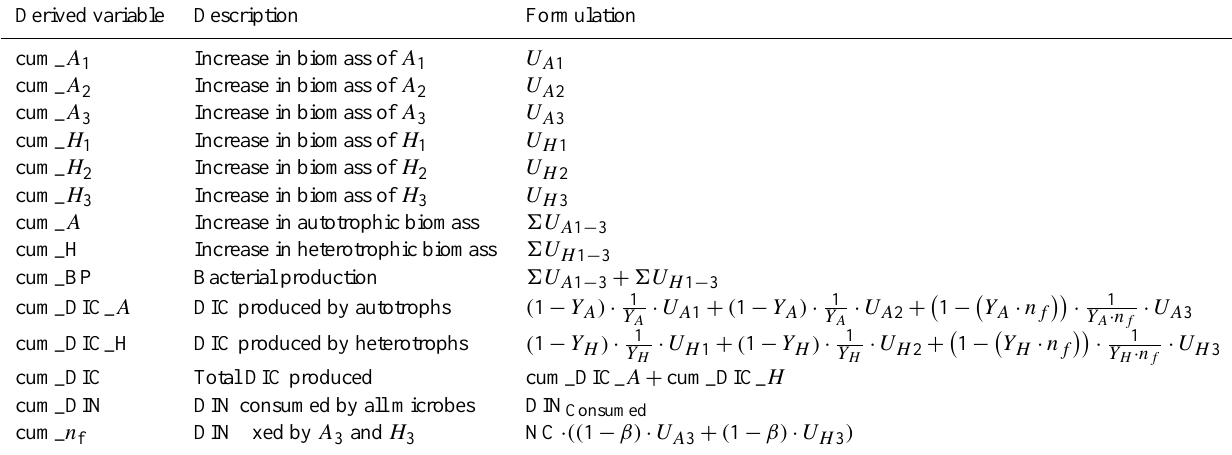
Table 3. Derived variables. Derived variable Description